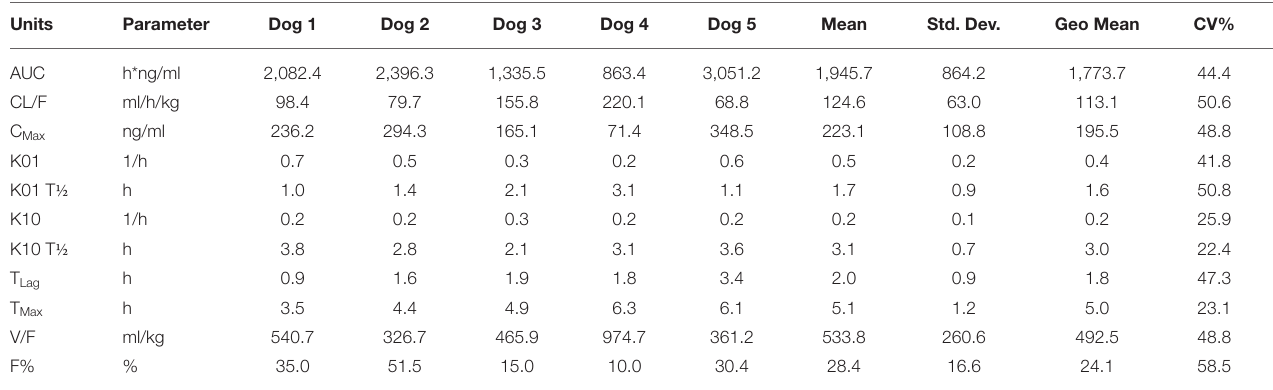
TABLE 3 | Summary of pharmacokinetic parameters following oral administration of apixaban, mean dose 0.2 mg/kg.